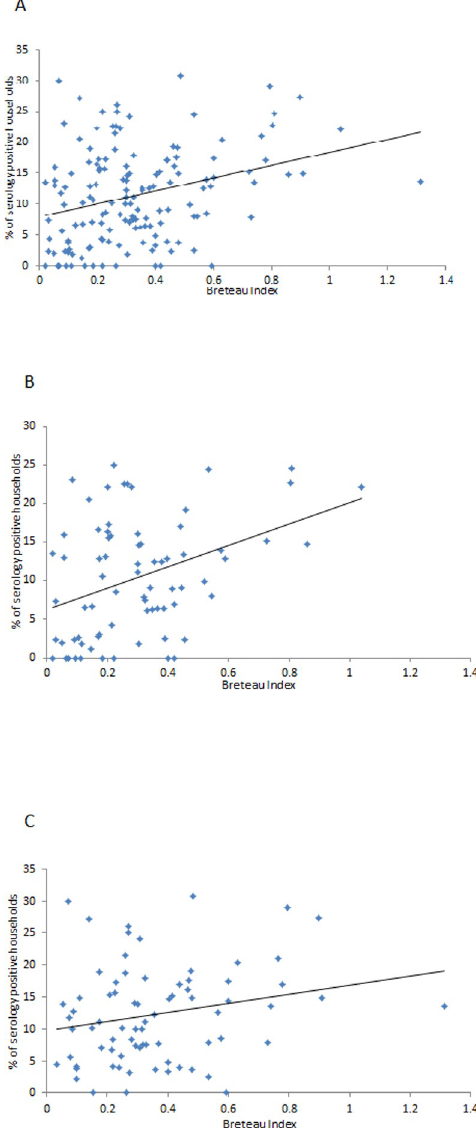
Fig 1. Breteau Index and proportion of serology positive households in clusters. In the scatter plots, each point represents a cluster. The vertical axis is the proportion of households in the cluster with at least one child with a doubling of dengue specific antibodies between paired saliva samples. The horizontal axis is the value of the Breteau Index in the cluster, averaged across two measurements three months apart. A. Scatter plot of Breteau Index and proportion of dengue serology positive households in all 150 clusters. B. Scatter plot of Breteau Index and proportion of serology positive households in 75 trial intervention clusters. C. Scatter plot of Breteau Index and proportion of serology positive households in 75 trial control